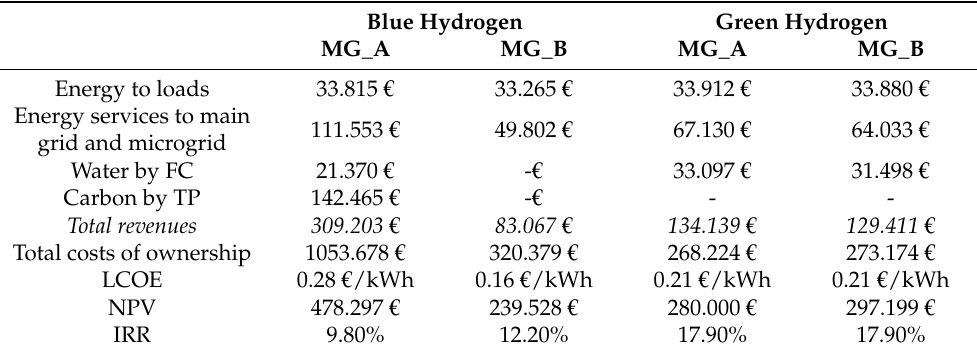
Table 5. Key financial ratios of the on-grid scenarios in North Europe (Bremen), 25 years project lifetime, green hydrogen cost: 3 € \ kg (0.25 € \ Nm 3 ), blue hydrogen cost: 0.85 € \ N m 3 , 5% discount rate. Revenues and TCO related to the first